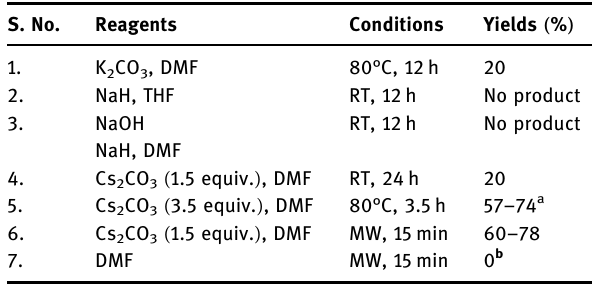
Table 1: Reaction conditions for O - alkylation of ( E )- 2 - styryl quino - line - 4 - ol